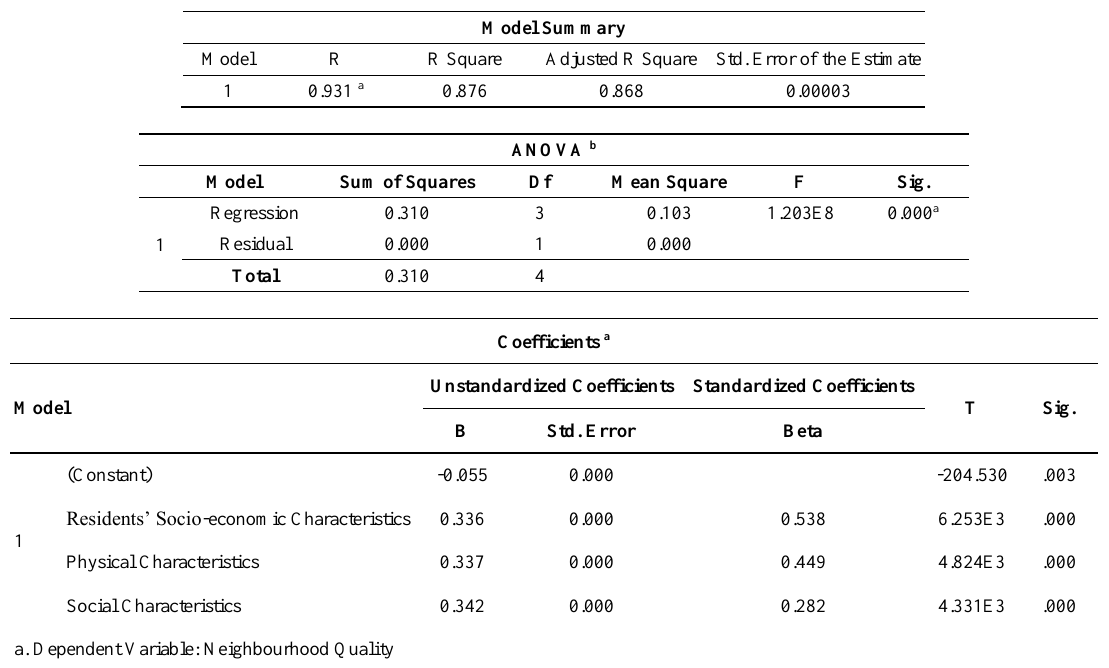
Table 17. Regression analysis showing the relationship between Residents’ Socio-economic Characteristics Physical Characteristics, Social Characteristics and Neighbourhood Quality in the Study